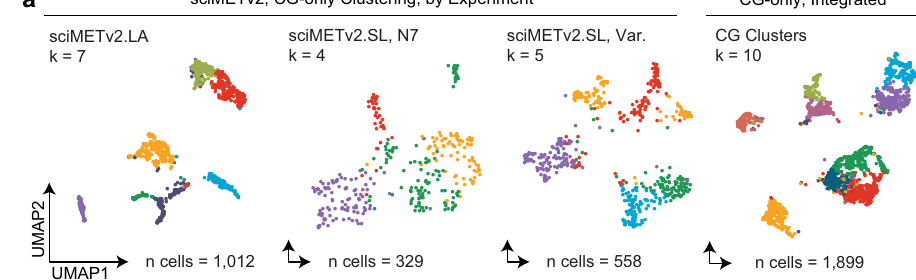
Fig. 7 | Analysis of sciMETv2 datasets using CG methylation alone. a UMAP projections colored by cluster foreachsciMETv2 experiment when analyzed using CG methylation alone and for the integrated sciMETv2 dataset processed (right).